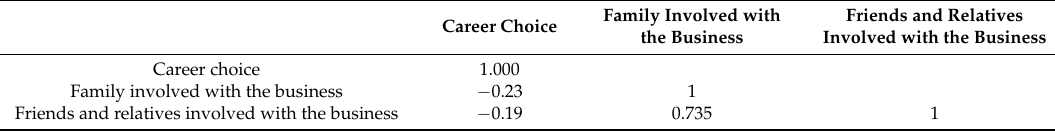
Table 10. Inter-correlation between perception about career choice and social learning theory